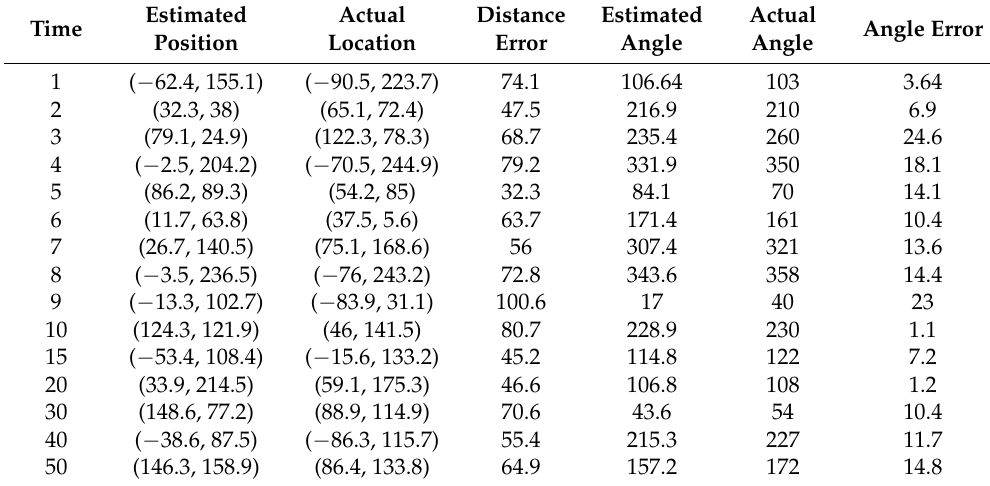
Table 11. Comparison of adding six-axis sensors (speed 200 mm/s).